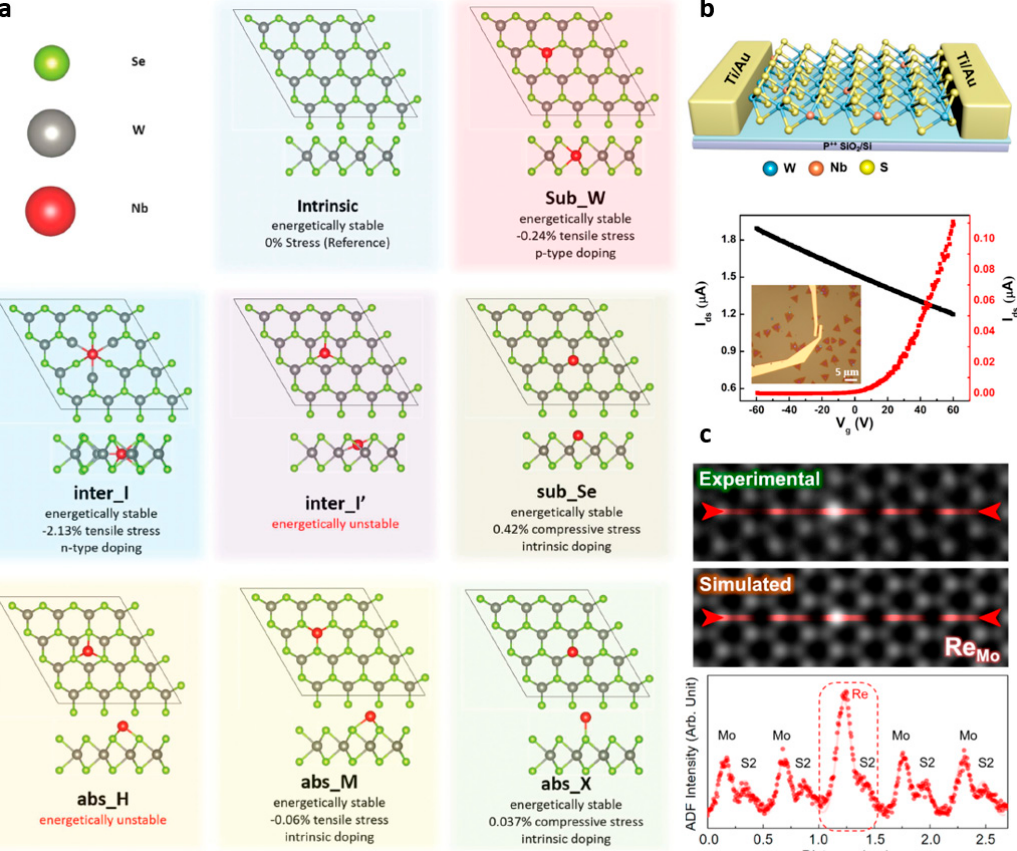
Figure 4. ( a ) Nb-doped WSe 2 monolayer for DFT calculations (adapted from [51] with permission from Royal Society of Chemistry). ( b ) Schematic of monolayer Nb x W 1 − x S 2 and transfer characteristics of the monolayer (black line is Nb x W 1 − x S 2 , red line is WS 2 ) (adapted from [55] with permission from ACS publications). ( c ) Experimental and simulated STEM images and line scans of Re and Mo dopants; the dots in the line scans represent experimental results, whereas the solid lines represent simulated results (adapted from [59] with permission from ACS publications).